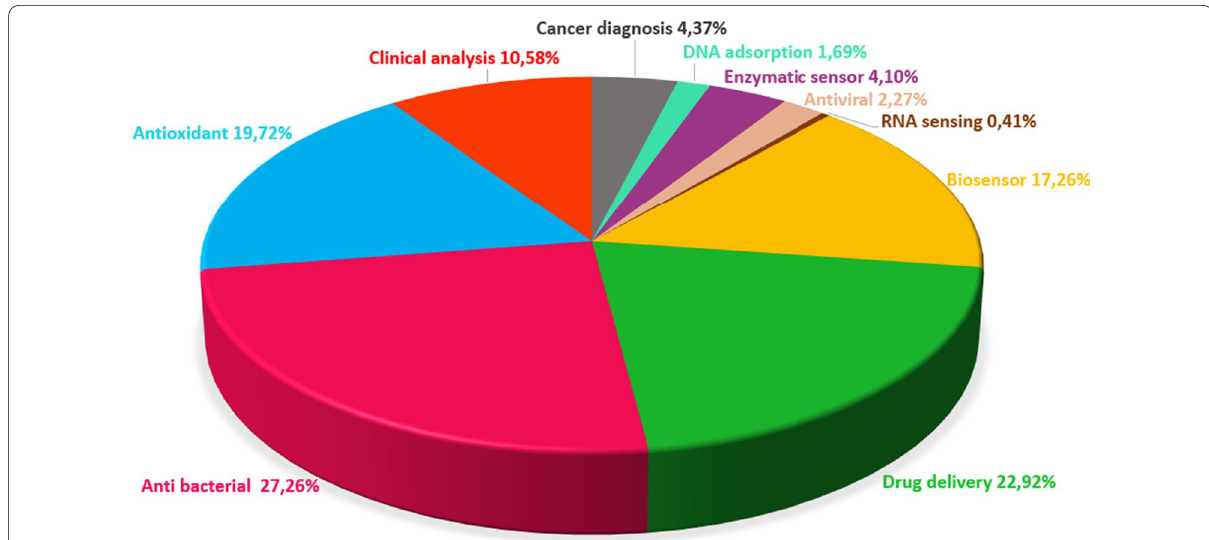
Fig. 2 Pie chart showing the distribution of MONs in biomedical